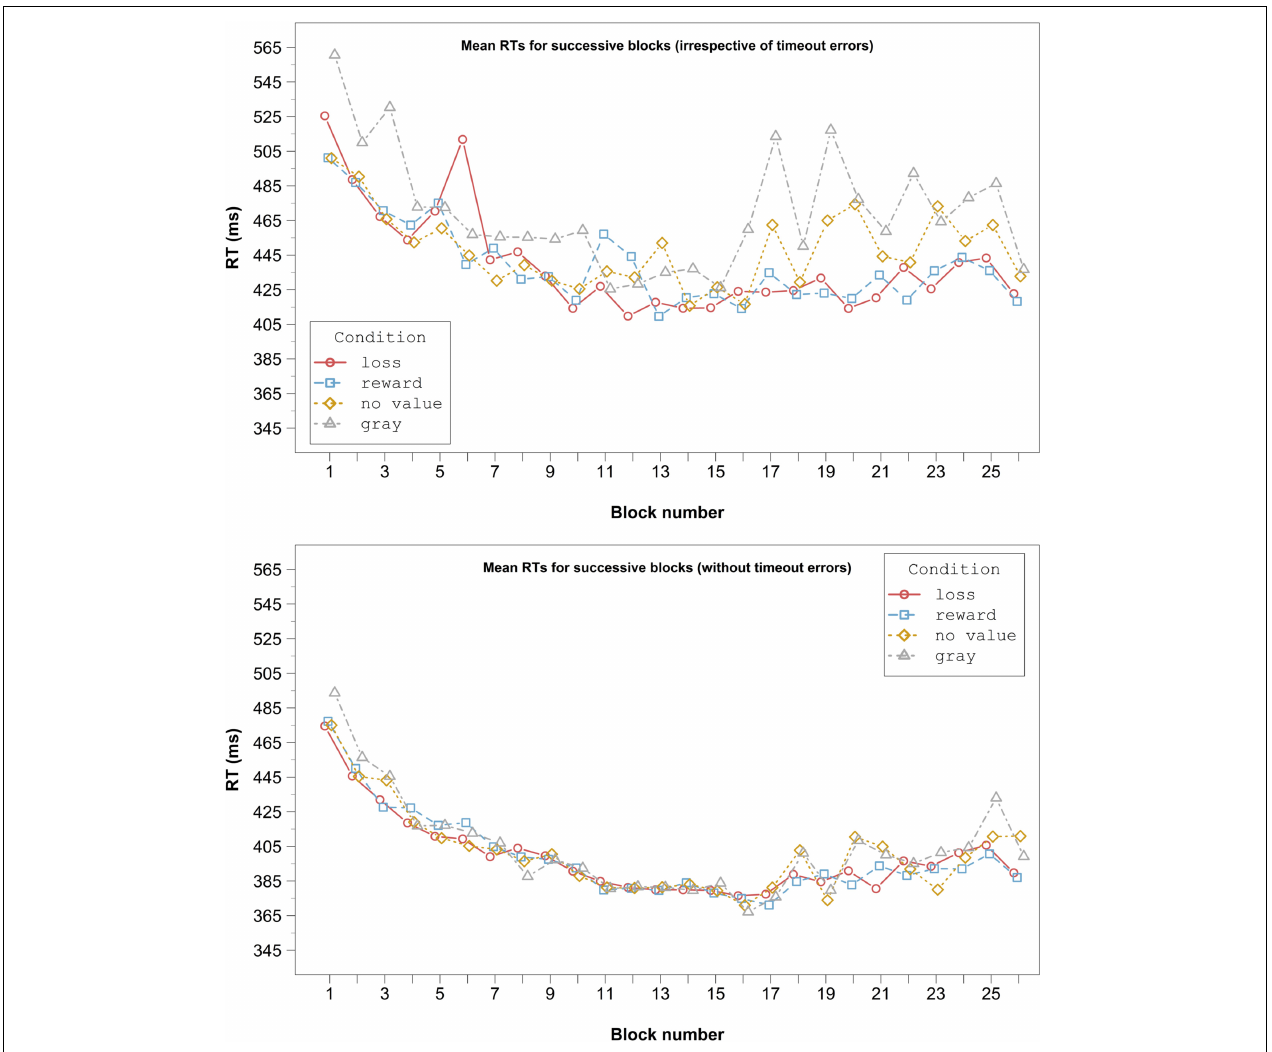
FIGURE 3 | RTs averaged across congruent and incongruent conditions for successive blocks in Experiment 1. The graph in the upper panel shows the complete data, irrespective of timeout errors. The graph in the lower panel displays only data in which the deadline was met. For clarity, error bars are not